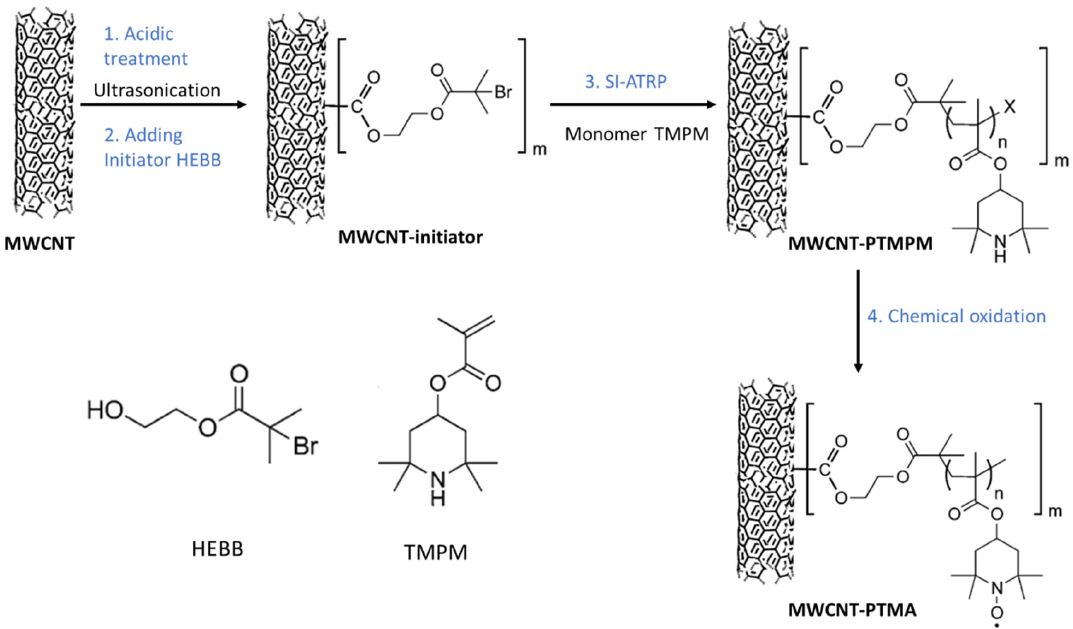
Figure 3. Preparation of poly(2,2,6,6-tetramethylpiperidin-1-oxyl-4-yl methacrylate) (PTMA)